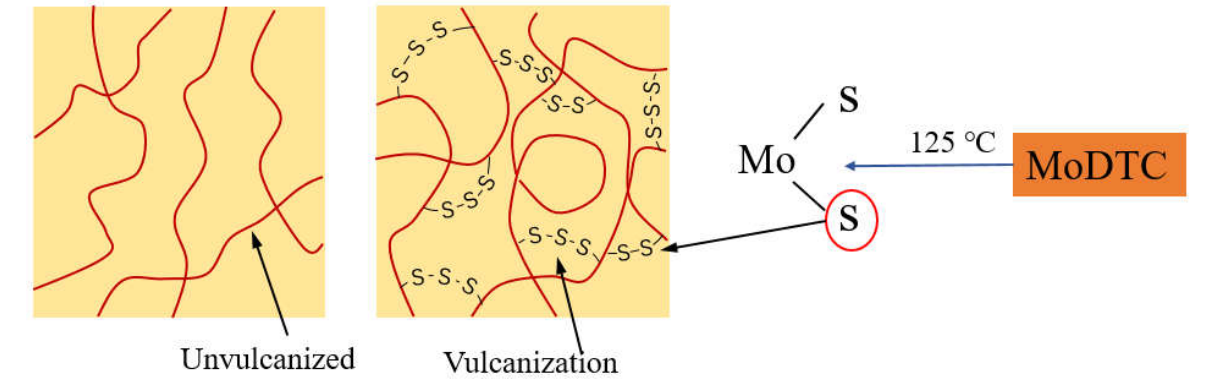
Figure 7. The process of MoS 2 participated in the vulcanization. Table 2. The vulcanization data of the compounds Test List